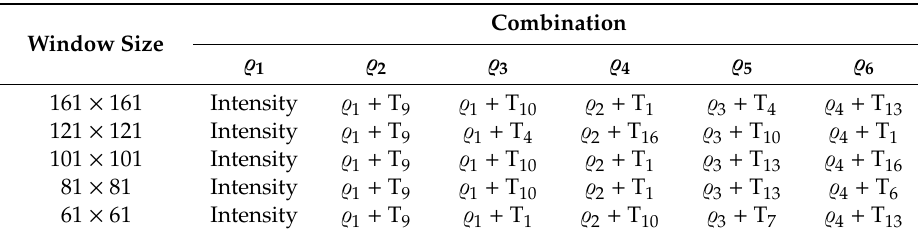
Table 4. Combinations of features for each window